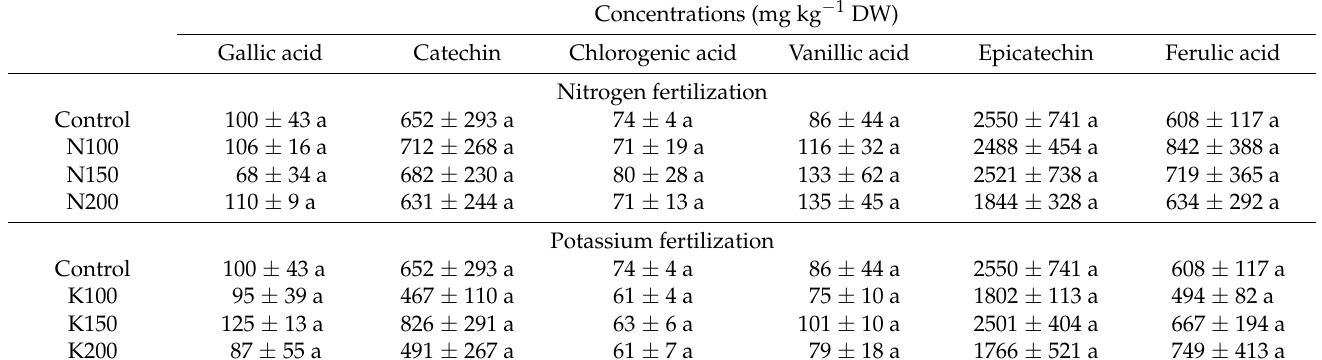
Table 1. Effects of different fertilization treatments on concentrations of polyphenolic compounds in shoots and roots of field-cultivated C. taiwanianum .